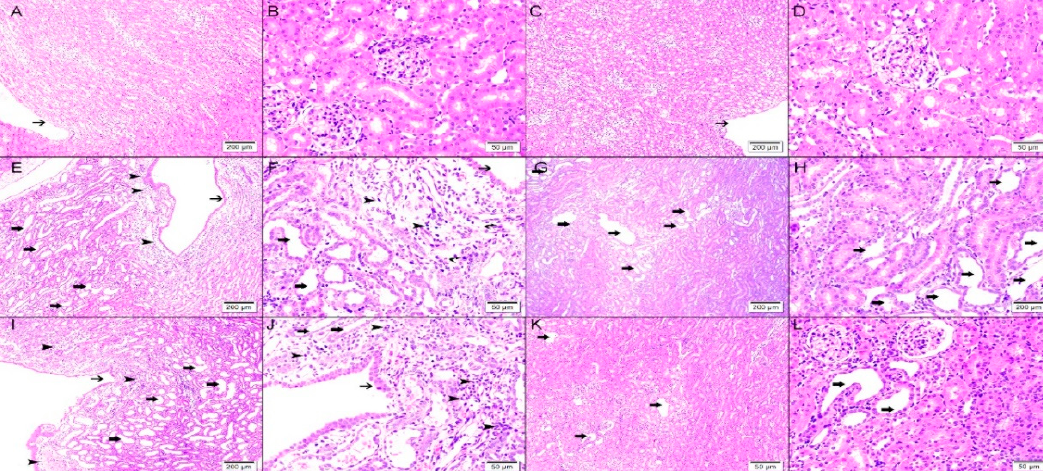
Figure 8. Histological features in the right non-obstructed and left obstructed kidneys six days post-UUO reversal in both Vx-2 and AG-2. Upper panel (right nonobstructed kidneys): ( A , B ), right kidney in Vx-2 showing normal kidney architecture and histology with no dilated tubules with normal calices (thin arrow); ( C , D ), right kidney in AG-2 with normal kidney architecture and histology and no dilated tubules with normal calices (thin arrow). Middle panel (left kidney in Vx-2): ( E , F ), shows collecting ducts dilation (thin arrow) in renal papillary area with dilated calices (thick arrow) with mild inflammatory cells infiltration of the renal papillae interstitial tissue consisting of lymphocytes mainly (arrow head); ( G , H ), the cortical and superficial medullary tissues show focal tubular dilatation (thick arrow). Lower panel (left kidney in AG-2): ( I , J ) shows collecting ducts dilation (thin arrow) in renal papillary area with dilated calices (thick arrow) with mild inflammatory cells infiltration of the renal papillae interstitial tissue consisting of lymphocytes mainly (arrow head); ( K , L ), the cortical and superficial medullary tissue show focal tubular dilatation (thick